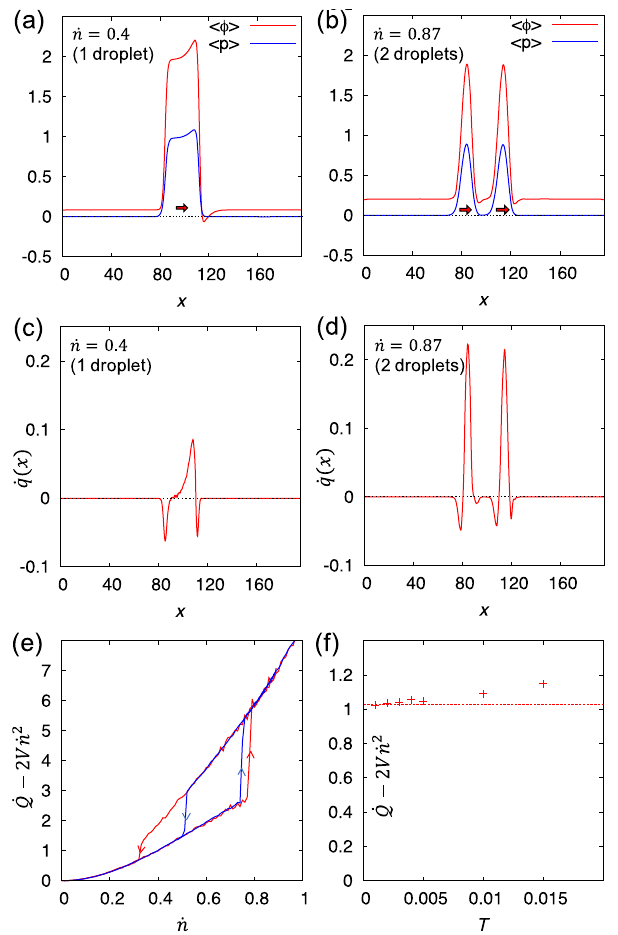
FIG. 5. (a),(b) The average profiles of density h ϕ ð x Þi and polarization h p ð x Þi , reported in the comoving frame of droplets moving toward x > 0 , show that polarization is nonzero only within droplets and its profile has a front-tail asymmetry. For multiple droplets, each one of them moves at the same velocity with a fixed separation distance. (c),(d) The corresponding average profiles of heat rate _ q ð x Þ , given in Eq. (43), are negative at the interface and increase monotonically from the tail to the front of each droplet. (e) The nontrivial contribution to heat rate R _ Q − 2 V _ n 2 _ qdx increases with the driving parameter _ n ¼ ϕ ¼ V _ n ≡ _ n of the motile polar droplets. Above a critical value of _ n , p when the droplet splits into two droplets, we observe a dis- _ Q − 2 V _ n 2 continuity of associated with a hysteresis loop whose _ Q − 2 V _ n 2 area increases with the speed at which _ n varies. (f) reaches a finite value at T ¼ 0 . Simulation details are